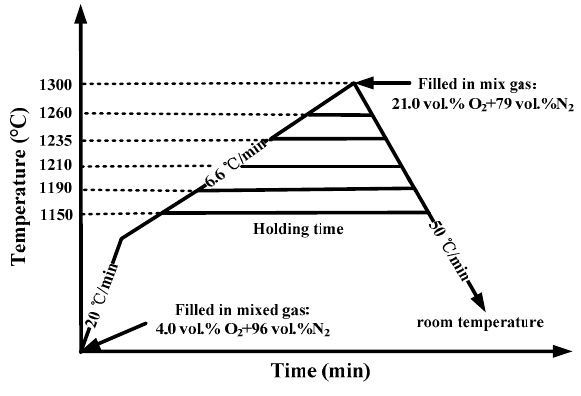
Figure 1. Oxidation experiment route.